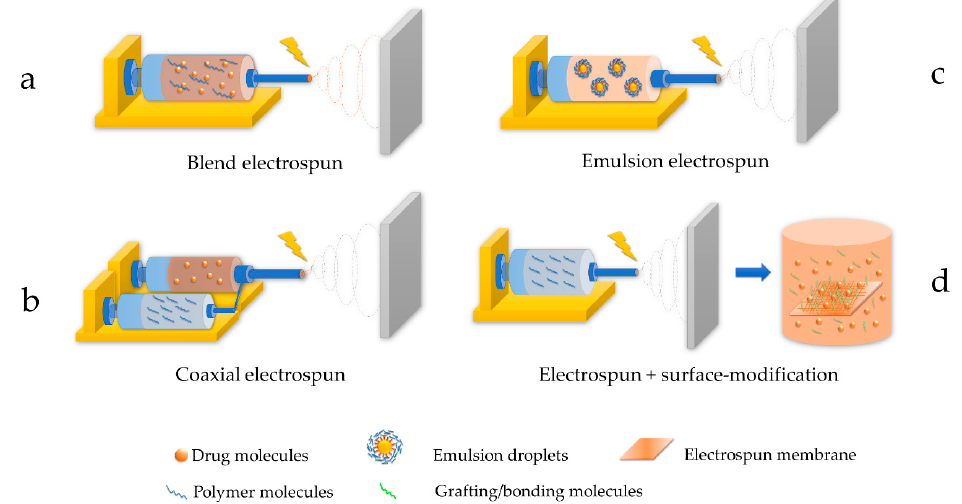
Figure 2. Typical electrospinning techniques to fabricate drug-loaded membranes including ( a ) blend electrospun (direct electrospun of polymer-drug blend). ( b ) coaxial electrospun (drug-core formu- lation and polymer-shell formulation being electrospun independently). ( c ) emulsion electrospun (electrospun of a thermodynamically stable drug-polymer formulation) ( d ) electrospun + surface modification (drug was absorbed or grafted to an electrospun film as a secondary